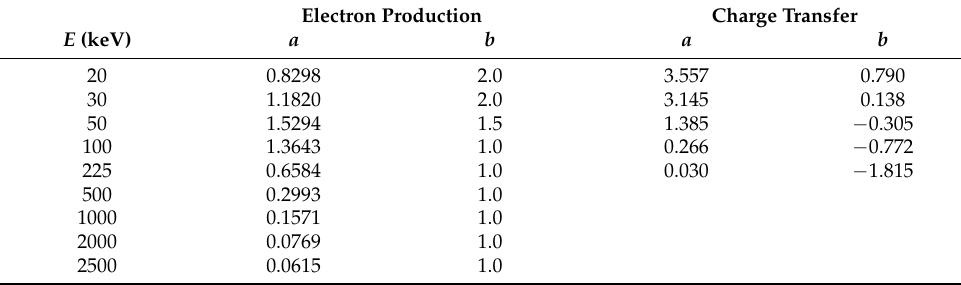
Table 3. Parameters of Equation (7) for the fit of the electron production and charge transfer at a given collision energy as a function of the ionization potential of the first 10 MOs (20–24 A (cid:48) and 1–5 A (cid:48)(cid:48) , see Table 2) of